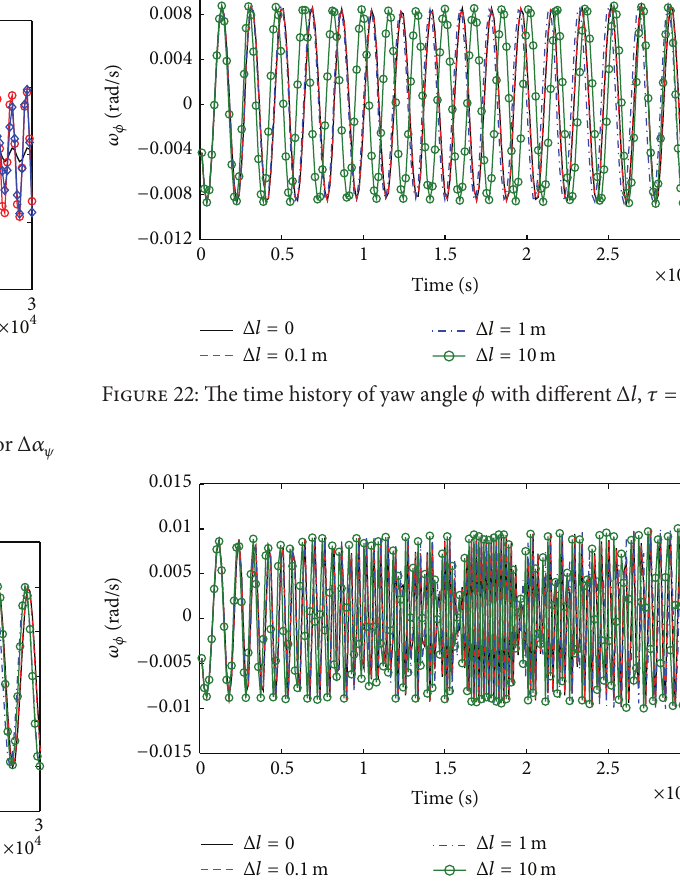
Figure 23: The time history of yaw angle 𝜙 with different Δ𝑙 , 𝜏 = 250 kN ⋅